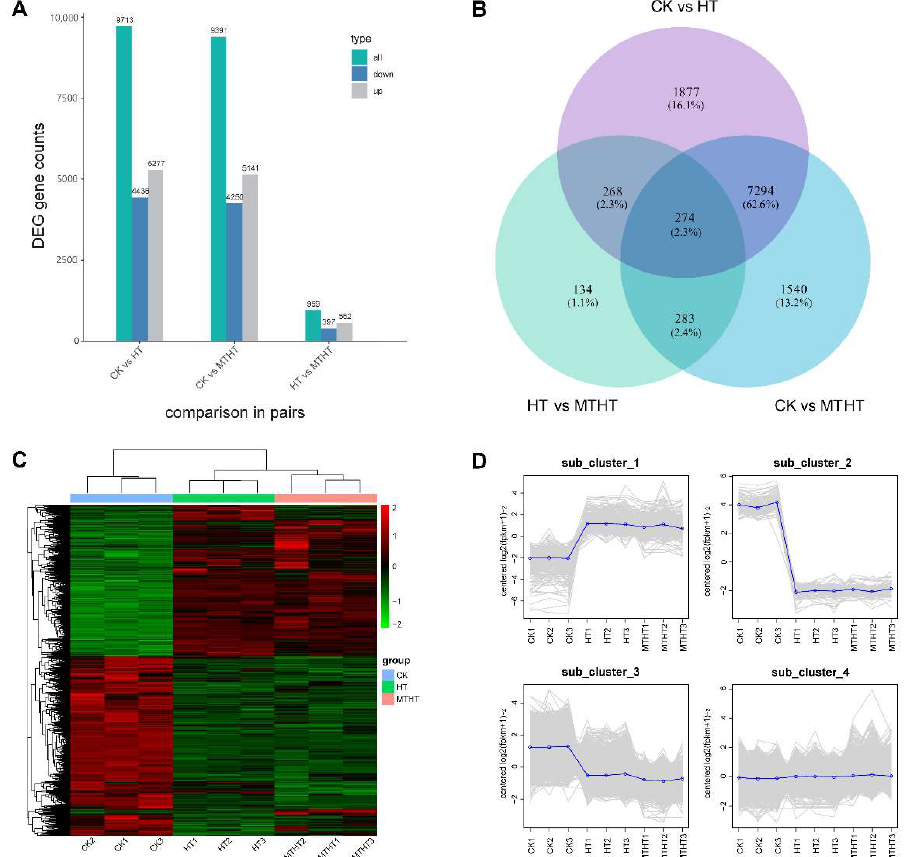
Figure 3. Distribution characteristics of differentially expressed genes (DEGs) in three different comparison groups. ( A ) The number of DEGs for any two different comparisons. Green indicates the number of all the differential genes, blue indicates the downregulated differential genes, and gray indicates the upregulated differential genes. ( B ) The Venn plot represents the number and proportion of DEGs that are commonly or uniquely expressed in pairwise comparisons. ( C ) Clustering of the DEGs’ transcript abundance in all samples. ( D ) K-means clustering of gene expression trends. The expression profile of each gene in each subpopulation is shown as a gray line, and the average expression profile of all the genes in each sample is shown in blue.